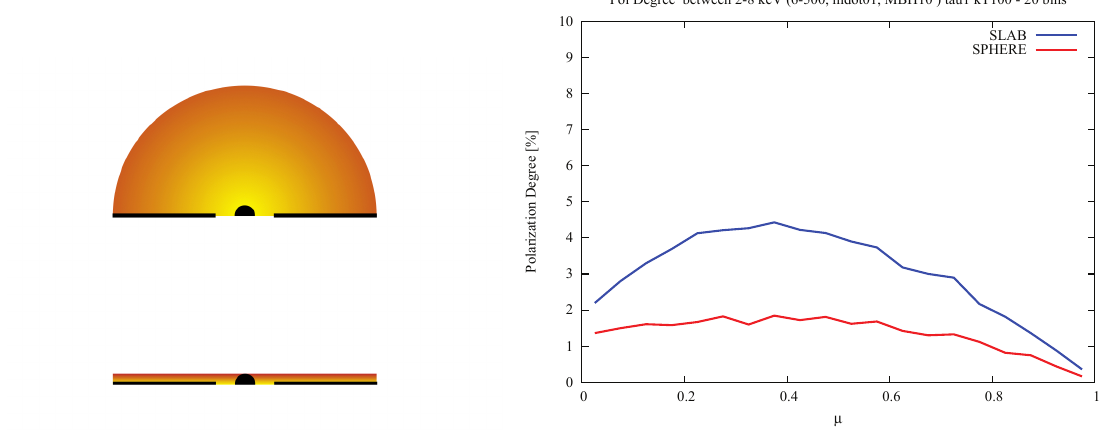
Figure 1. The 2–8 keV polarization degree ( right panel ) for a spherical and a slab geometry ( left panel ) of the Comptonizing corona. See text for